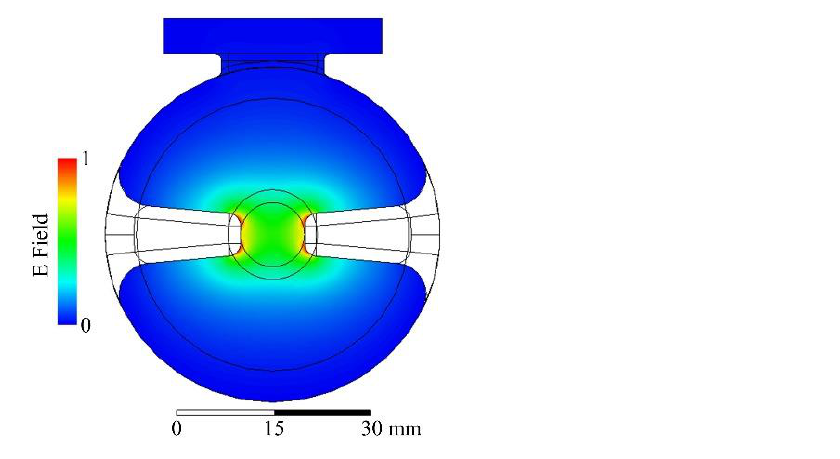
Figure 19. Electric field profile of the TE11-like mode shown in a cross-section of the deflector cell, with beam axis oriented into the page. The opposing posts (profiles shown in white) produce an RF dipole. Power is coupled in through the port at the top of the model simulated in ANSYS-HFSS.